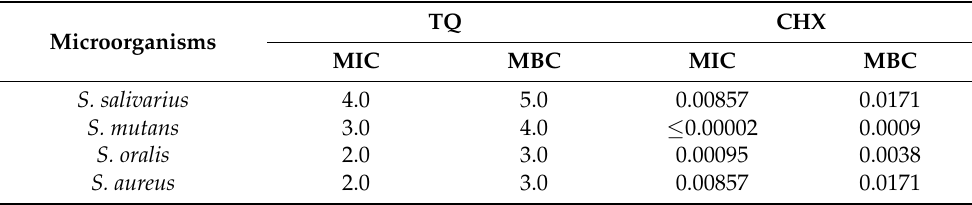
Table 2. Minimum Inhibitory and Bactericidal Concentration (mg/mL) of TQ and positive control CHX against the four bacterial strains .